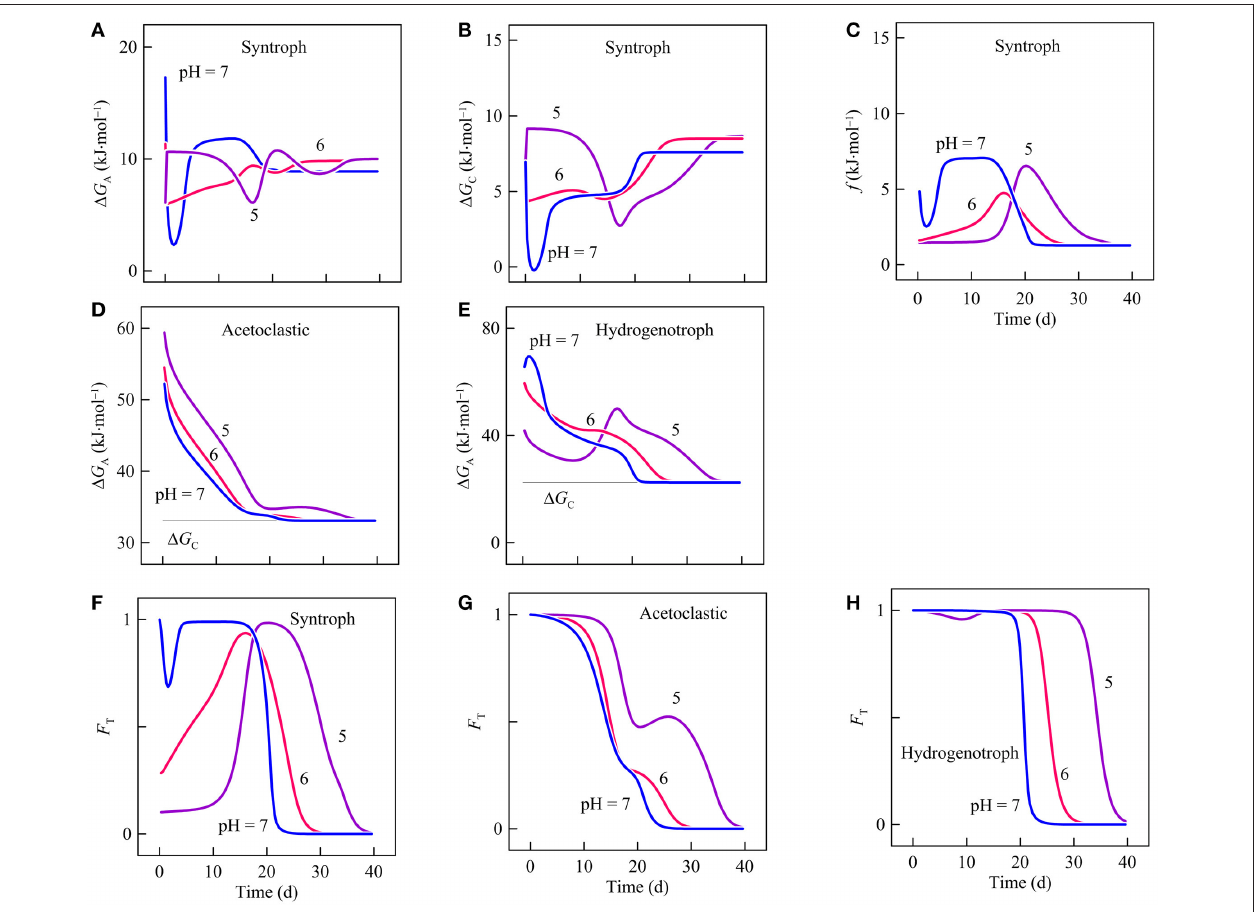
FIGURE 7 | Variation with time in the energy available (A) , the conserved energy (B) , and the thermodynamic drive (C) of strain IB, the energy available to Methanosarcina mazei (D) and to Methanobacterium formicium (E) , and the thermodynamic factor of syntrophic butyrate oxidation (F) , acetoclastic methanogenesis (G) , and hydrogenotrophic methanogenesis (H) in batch reactors of differ pHs. Lines are the results of biogeochemical reaction modeling, accounting for the impact of pH on the energy available from microbial